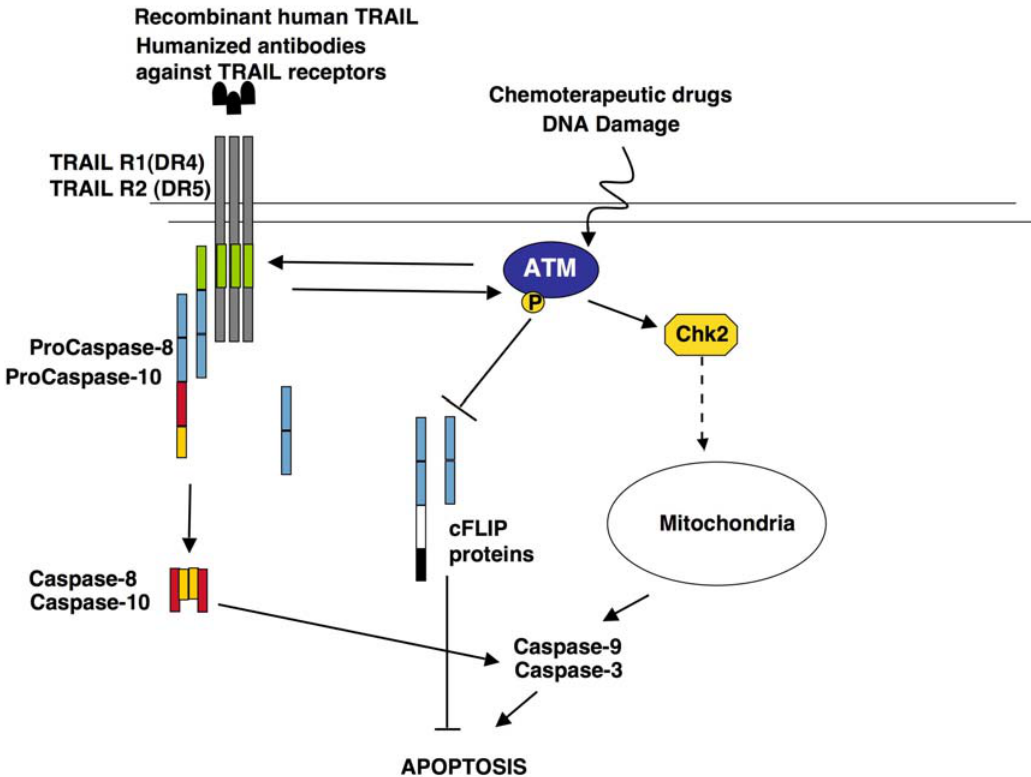
Figure 1. ATM kinase activity modulates TRAIL sensitivity. DNA damaging agents trigger ATM kinase activity which in turn modulates TRAIL sensitivity through three mechanisms: (1) ATM activity promotes TRAIL R2 expression [115]; (2) TRAIL-R1 and TRAIL-R2 stimulation, further promote ATM catalytic activity [117,118] and triggers downstream Chk2 activation, which triggers Caspases activation through the mitochondria pathway [117]; (3) ATM activity directly down regulates cFLIP proteins levels